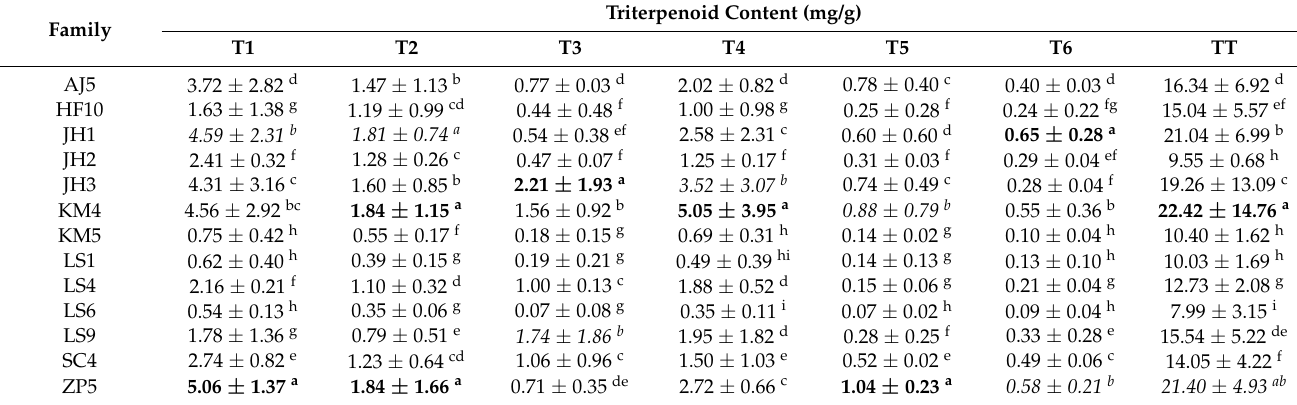
Table 3. Mean triterpenoid contents in the leaves of 13 C. paliurus genotypes across two test